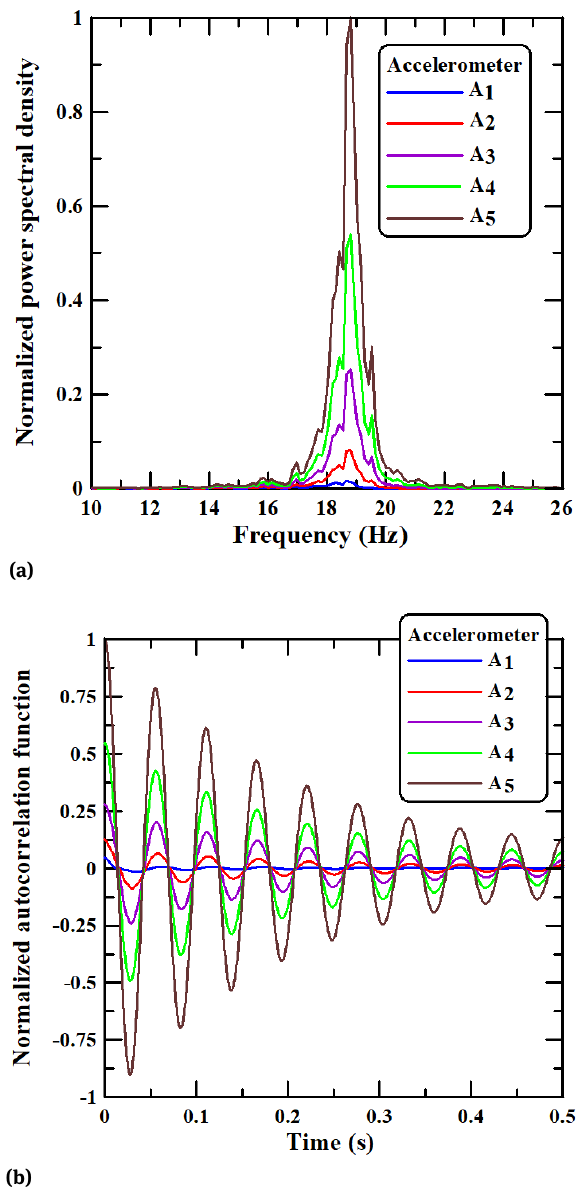
Figure 6: (a) Normalized power spectral density plot and (b)